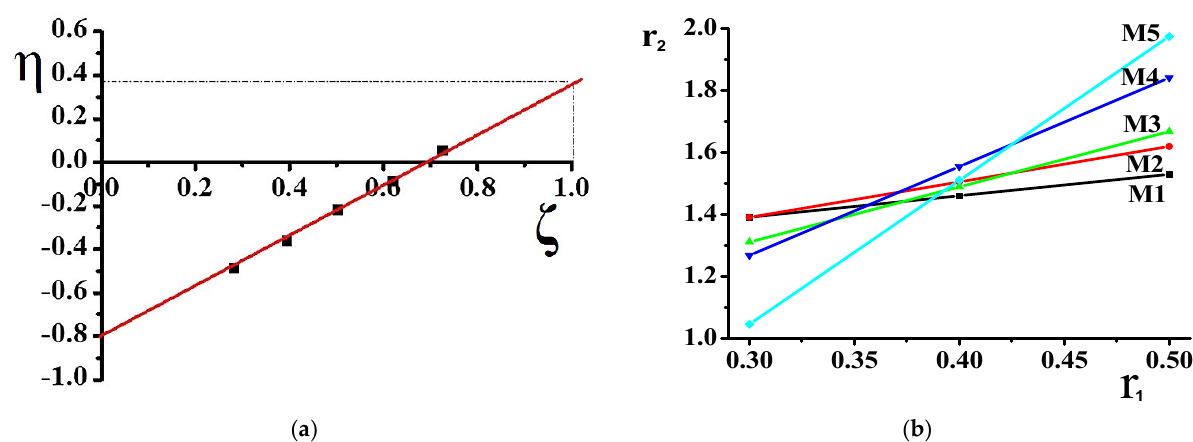
Figure 3. Kelen–Tudos ( a ) and Mayo–Lewis ( b ) plot of poly(DMA ‐ co ‐ AAc) copolymer. Table 2. Copolymer constants based on Fineman–Ross, inverted Fineman–Ross, Kelen–Tudos and Mayo–Lewis methods.